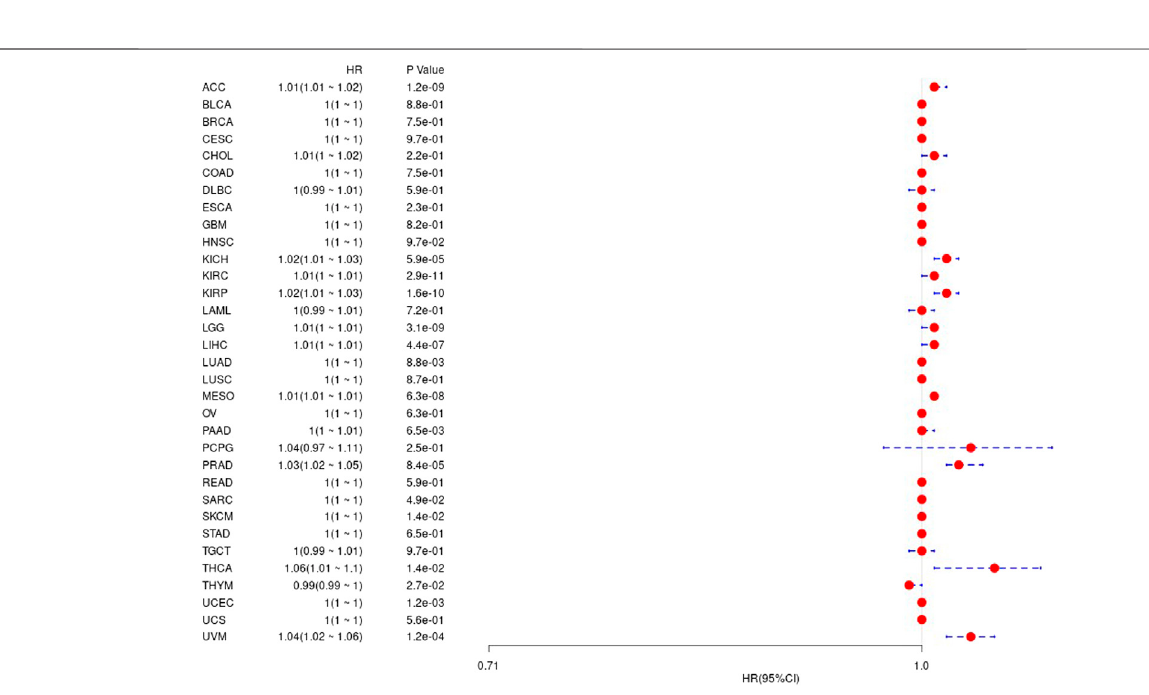
Frontiers in Genetics |